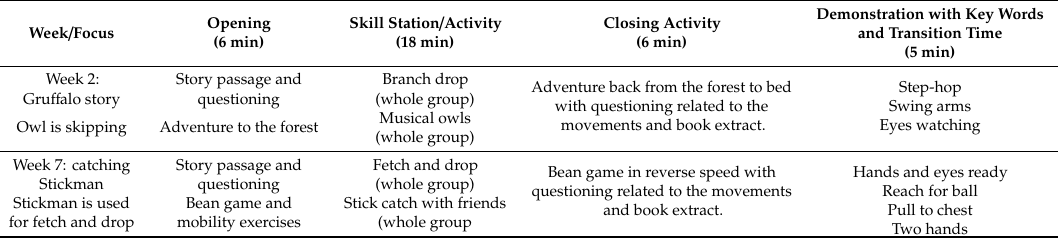
Table 1. Example of the movement and storytelling programme for two